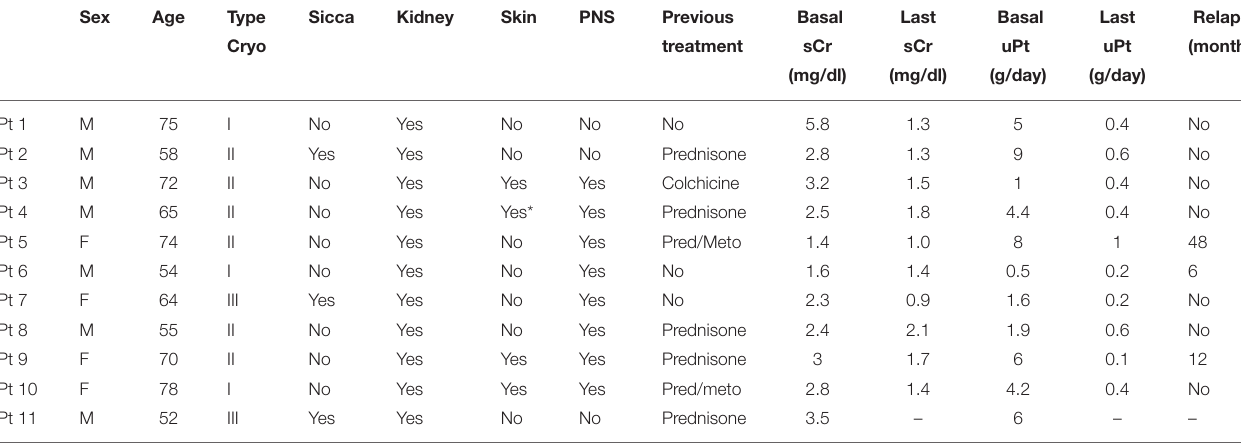
TABLE 1 | Detailed data about demographic and clinical characteristics and follow-up of the 11 individual patients.